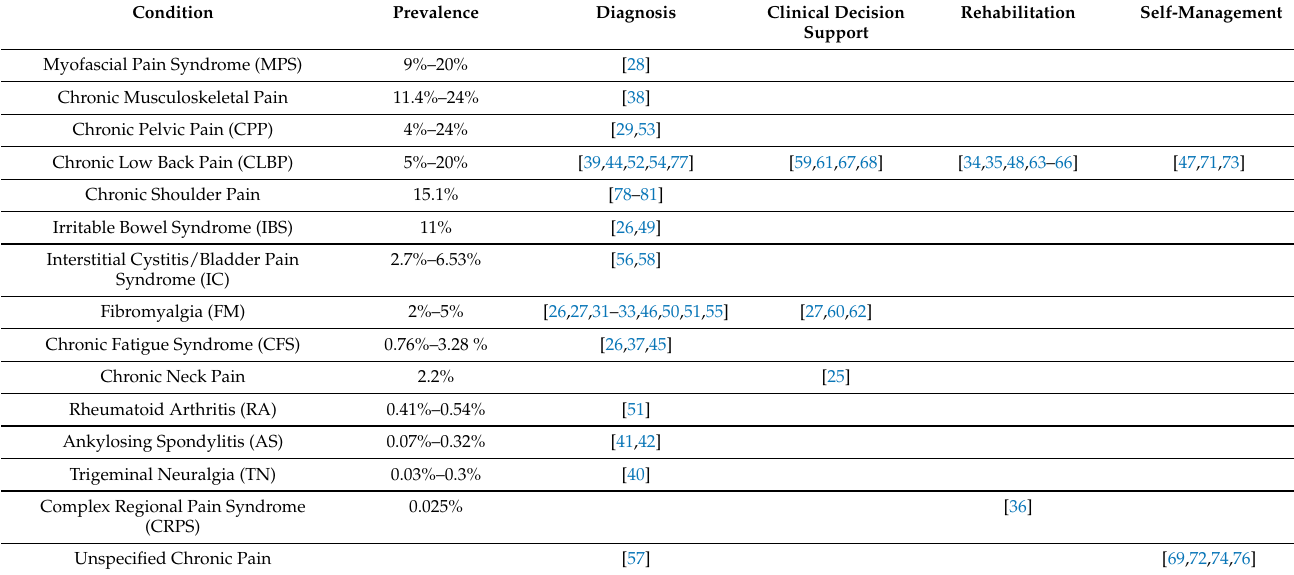
Table 3. Applications of machine learning studies on different types of chronic pain (prevalence sources: